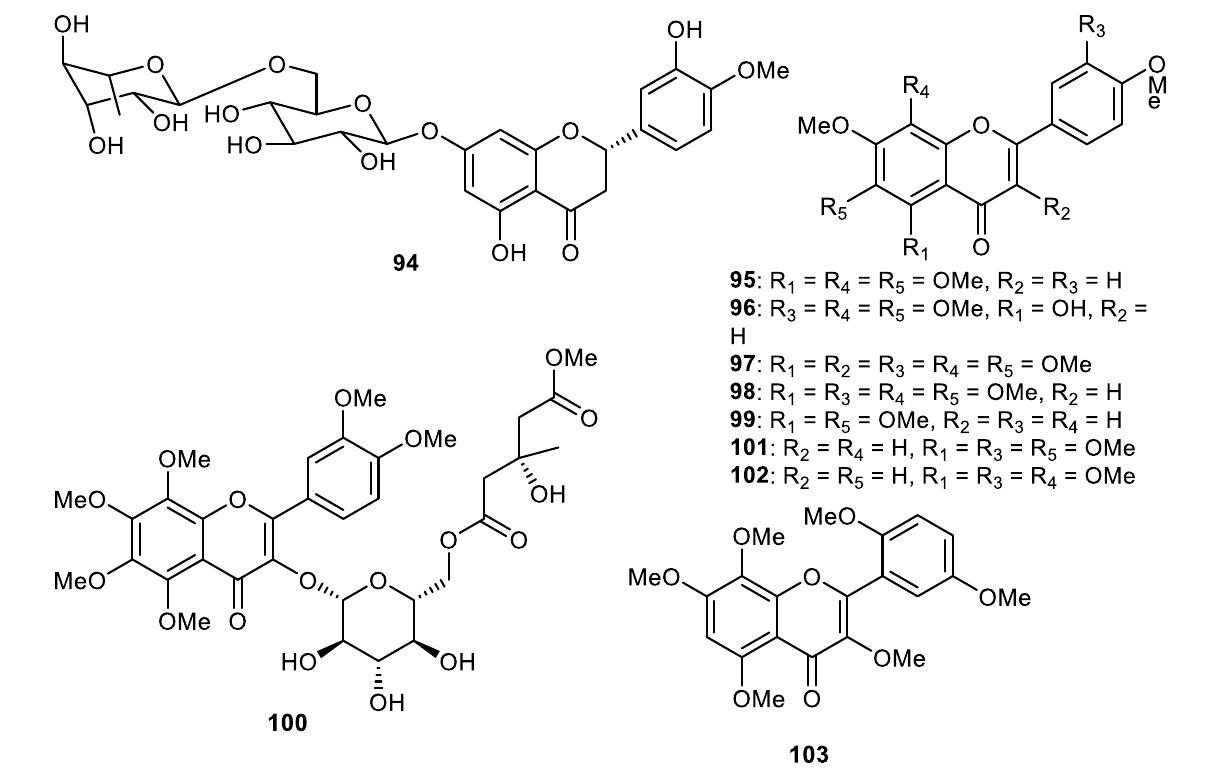
Figure 12. Structures of flavonoids 94 – 103 .